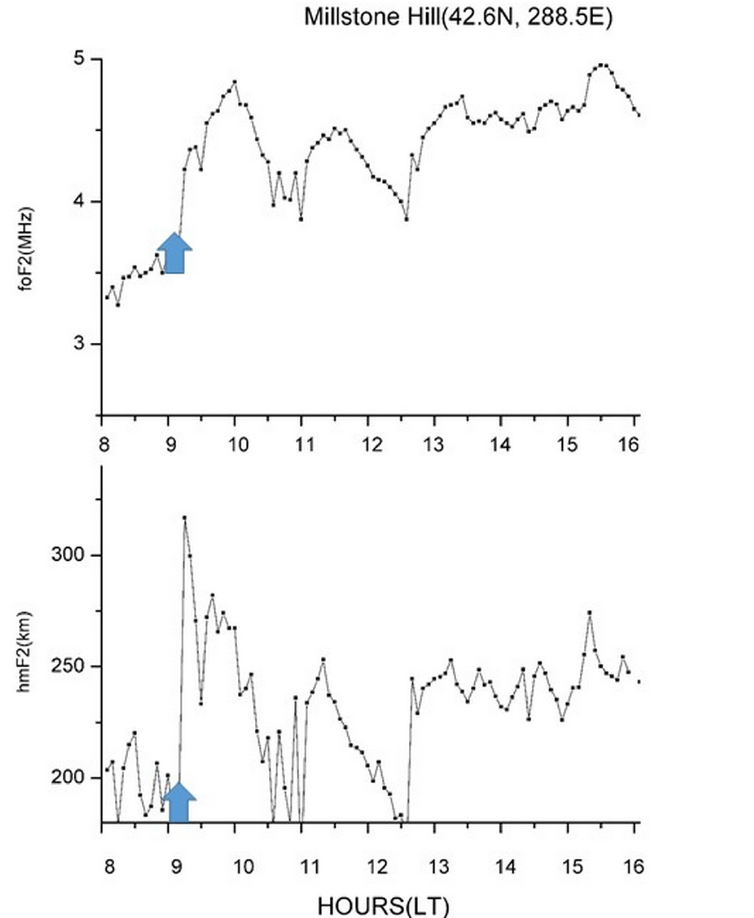
Figure 9. foF2 and hmF2 variations at Millstone Hill between 08 and 16 LT on 4 November 2021. The blue arrows indicate the hmF2 and foF2 increase due to the